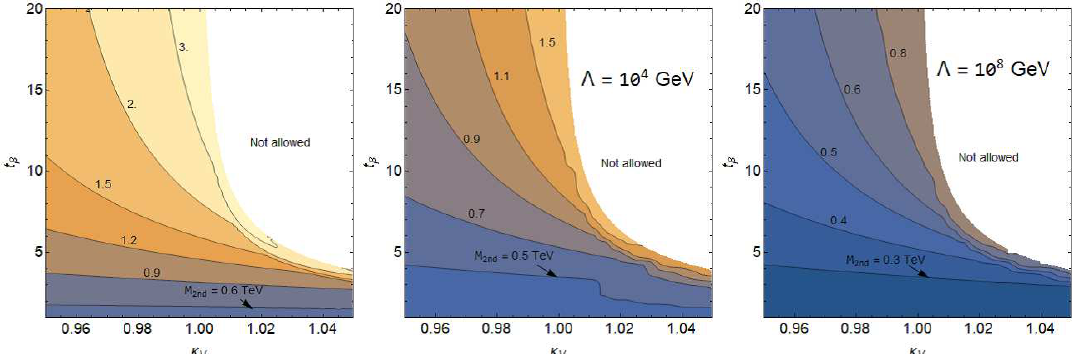
Figure 4 . Upper limit on M 2nd = Min( m function of κ V in the GM model with t β = 1 , 2 , 3 (left panel) and t β = 5 , 10 , 20 (right panel).